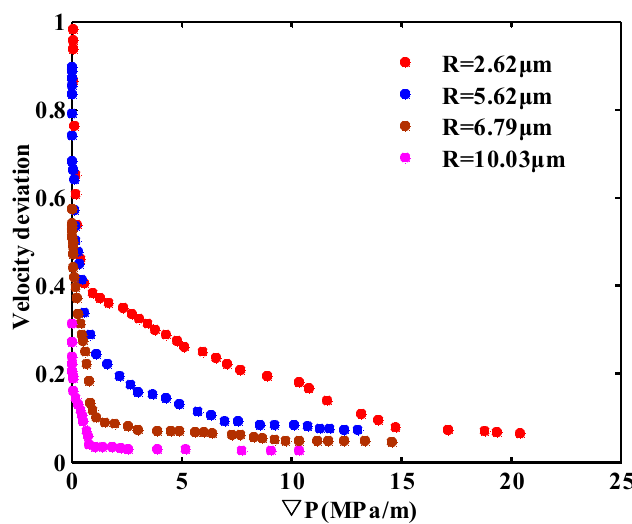
Figure 3. Relationship of velocity deviation versus displacement pressure gradient in different radial micro-tubes.